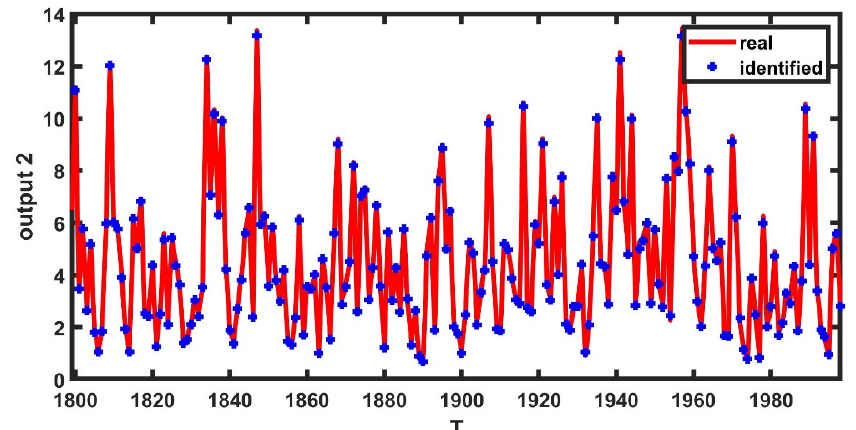
Figure 7. The real output 2 and the identified output 2.